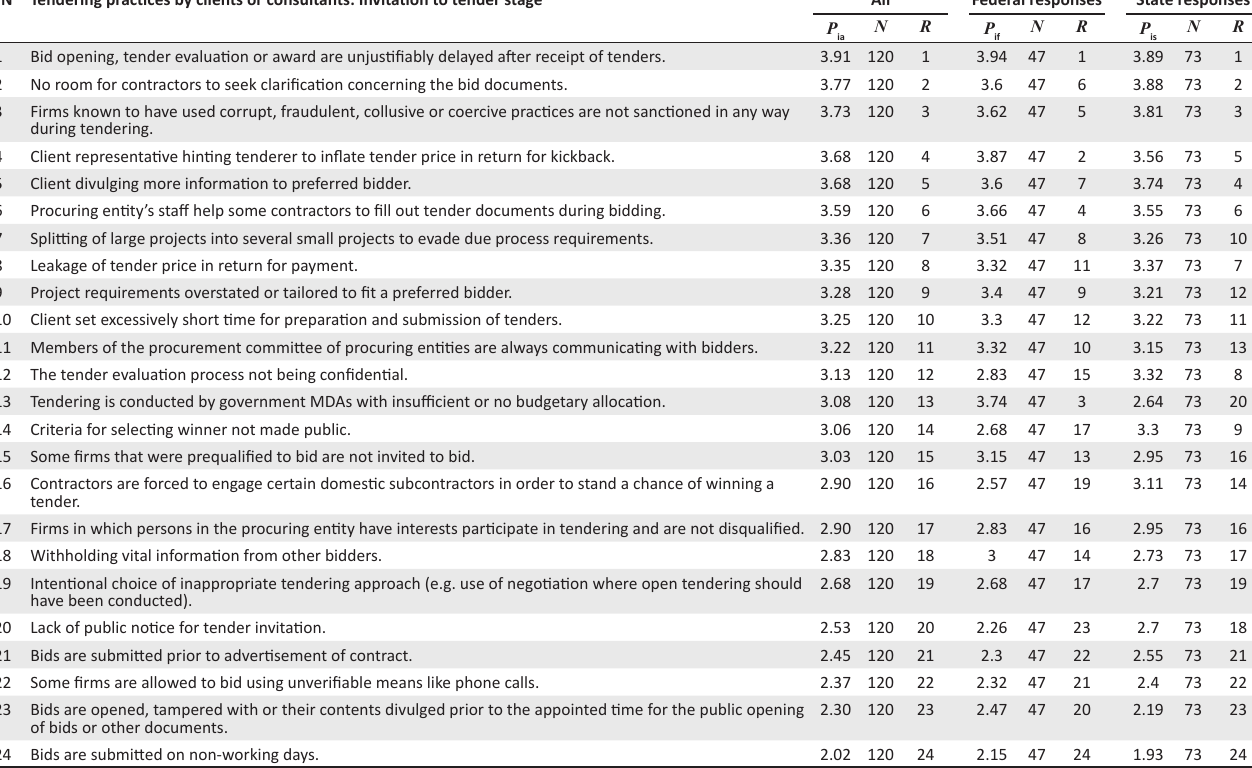
TABLE 4: Responses on the unethical tendering practices of clients or consultants at the invitation to tender stage. S/N Tendering practices by clients or consultants: Invitation to tender